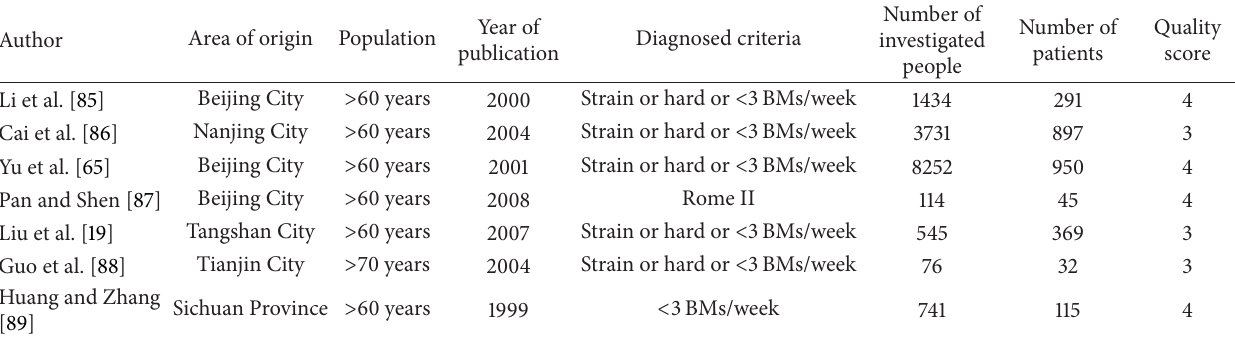
Table 3: Characteristics of included papers (in elderly population).